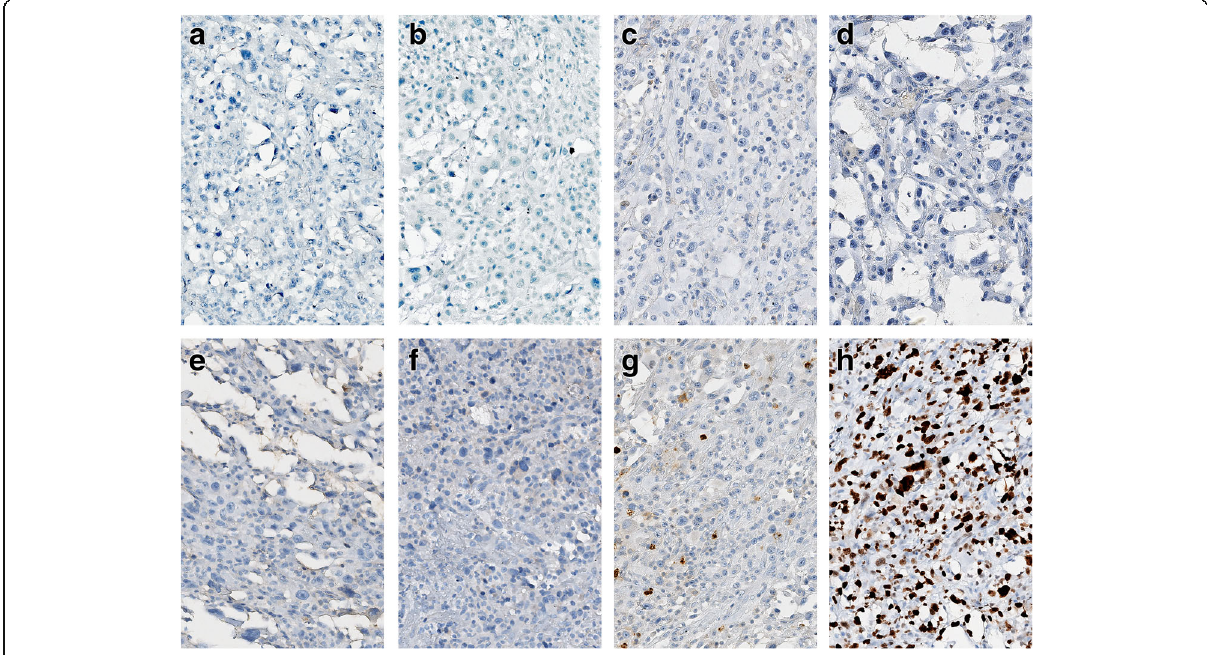
Fig. 5 Negative immunostaining for Calretinin ( a ), CK5/6 ( b ), EMA ( c ), HBME-1 ( d ) TTF-1 ( e ), Thyroglobulin ( f ), CEA ( g ). Positive nuclear immunostaining for Ki67 ( h ). a - h : 200×, immunoperoxidase